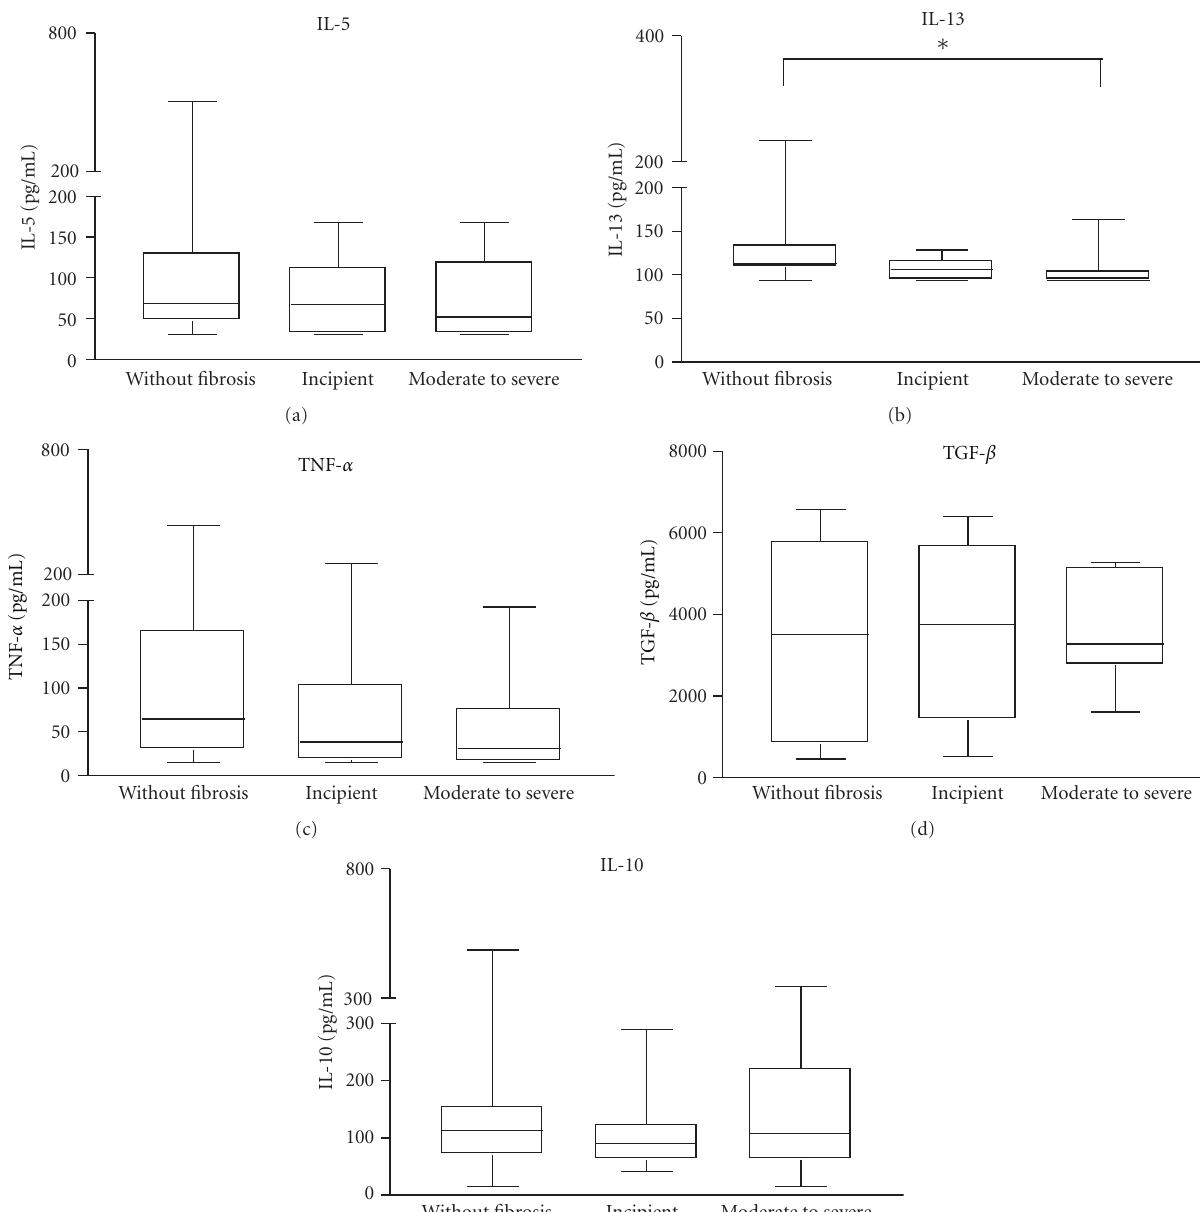
Figure 1: Serum cytokine levels in schistosomiasis individuals with di ff erent degrees of periportal fibrosis: (first box) individuals without fibrosis ( n = 30), (second box) incipient fibrosis ( n = 25), and (third box) moderate to severe periportal fibrosis ( n = 17). Levels of IL-5, IL- 13, TNF- α , TGF- β , and IL-10 were determined by sandwich ELISA technique. Horizontal lines represent the median values, boxes represent the 25th to the 75th percentiles, and vertical lines represent the 10th to 90th percentiles. Asterisks indicate statistically significant di ff erences ( P < 0 . 05;